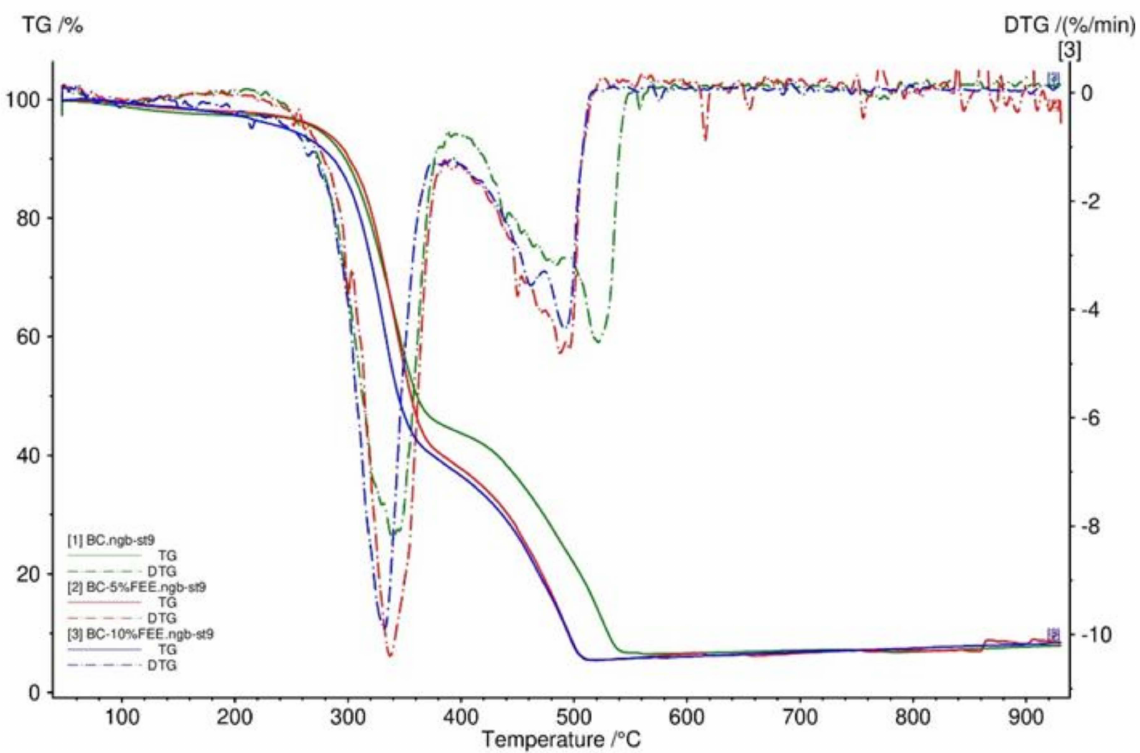
Figure 5. TG and DTG curves of BC membranes—BC (green), BC-10%FEE (blue), and BC-5%FEE